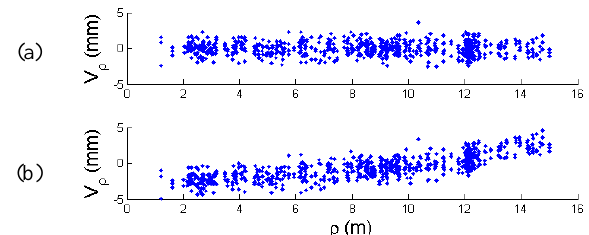
Figure 1: (a) Range residuals versus range plot in point-based self-calibration for panoramic scanners without systematic errors. (b) Unmodelled 5 mm rangefinder offset.